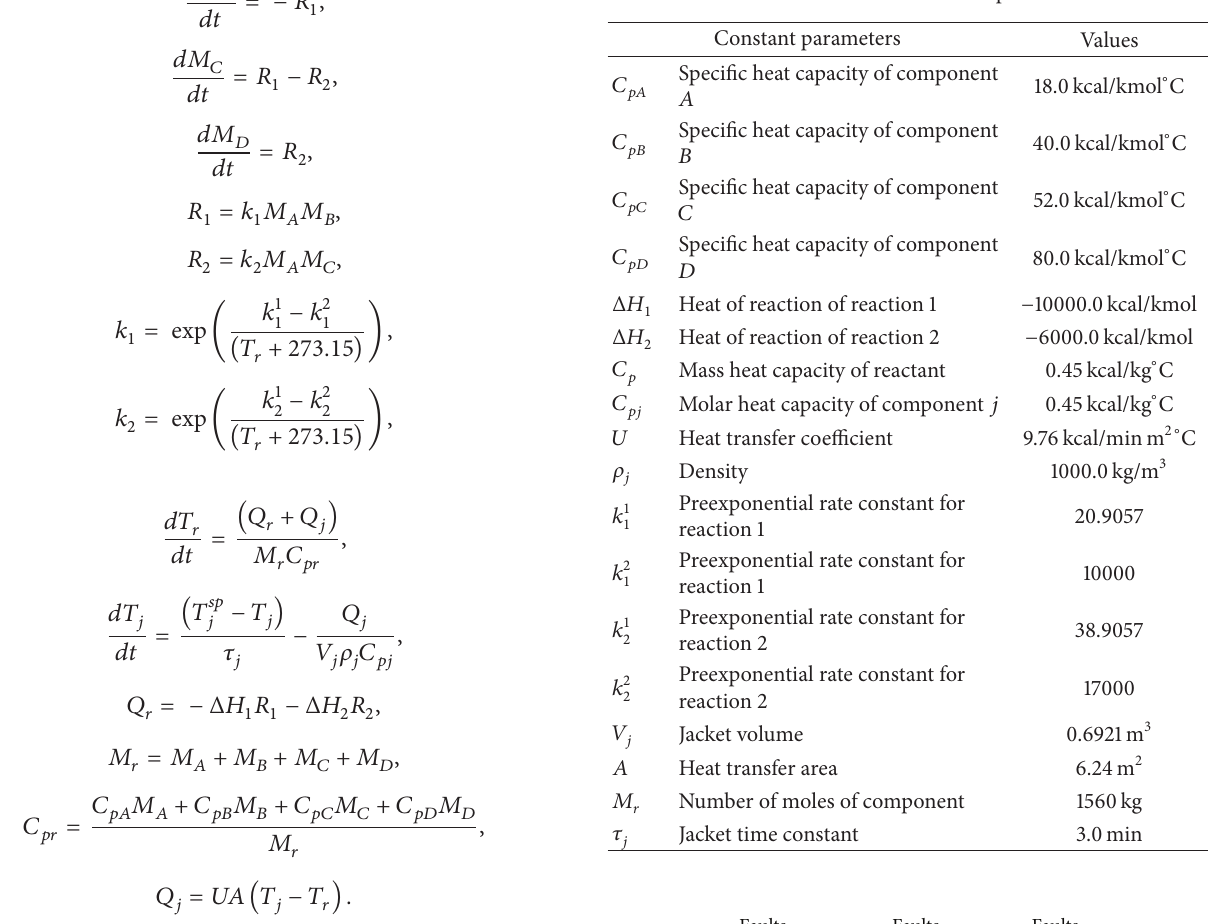
Table 1: Nominal values of the parameters.